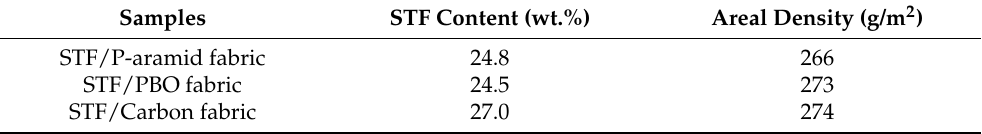
Table 4. Specification of the fabrics with STF.